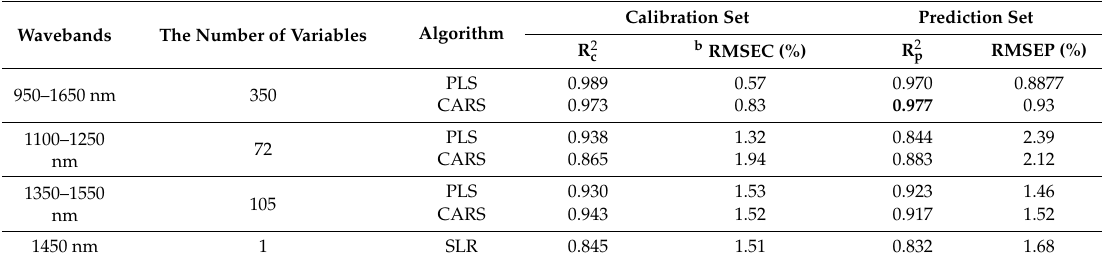
Table 2. The model performance of three bands by PLS and